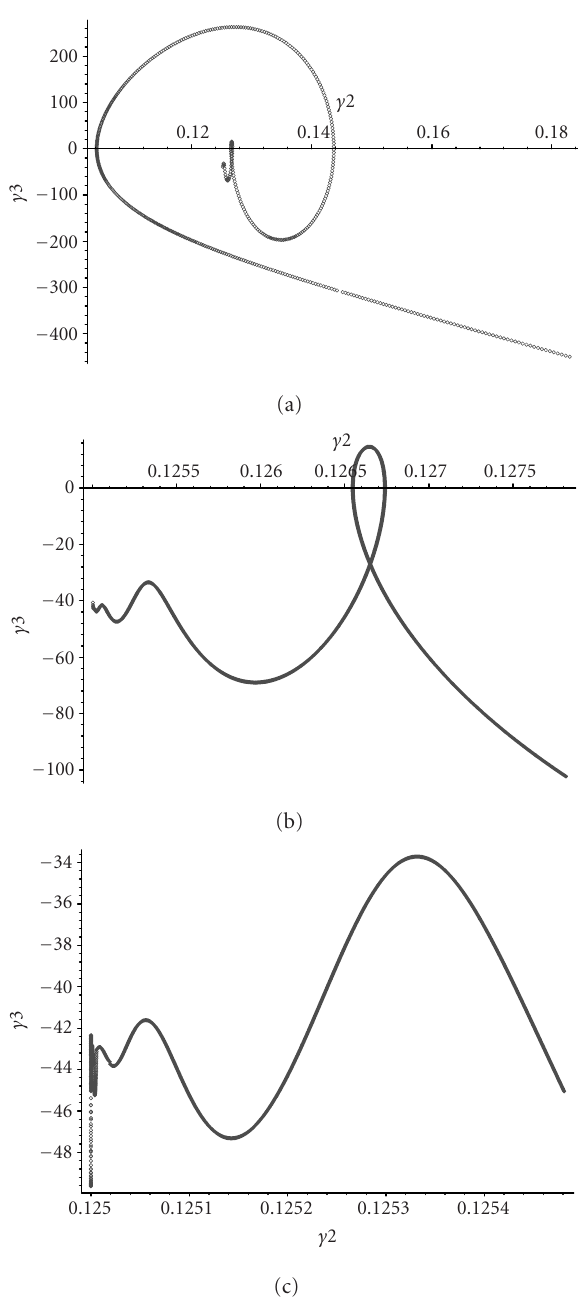
Figure 5.5. The smaller pattern approached in Figure 5.4 is shown in detail, now displaying a some- what di ff erent general pattern. Here, ¨ ε enters oscillations as ε approaches the neighborhood of unity. (a) and (b) show enlargements of the inner loop, and (c) shows the endpoint in more